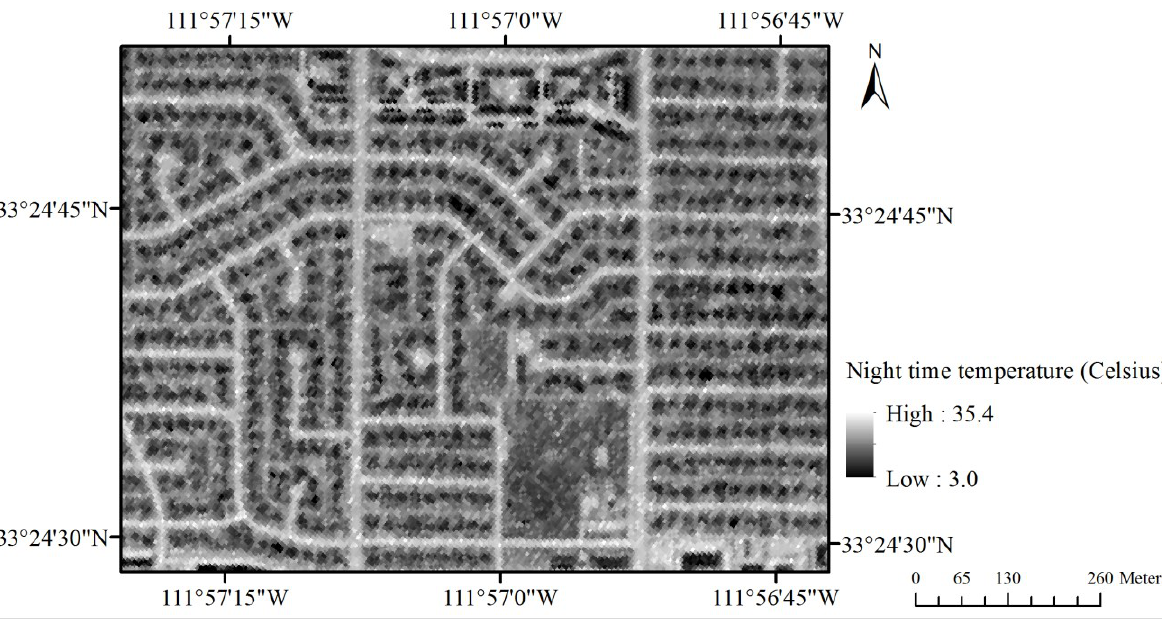
Figure 17. Night time temperature derived from MASTER